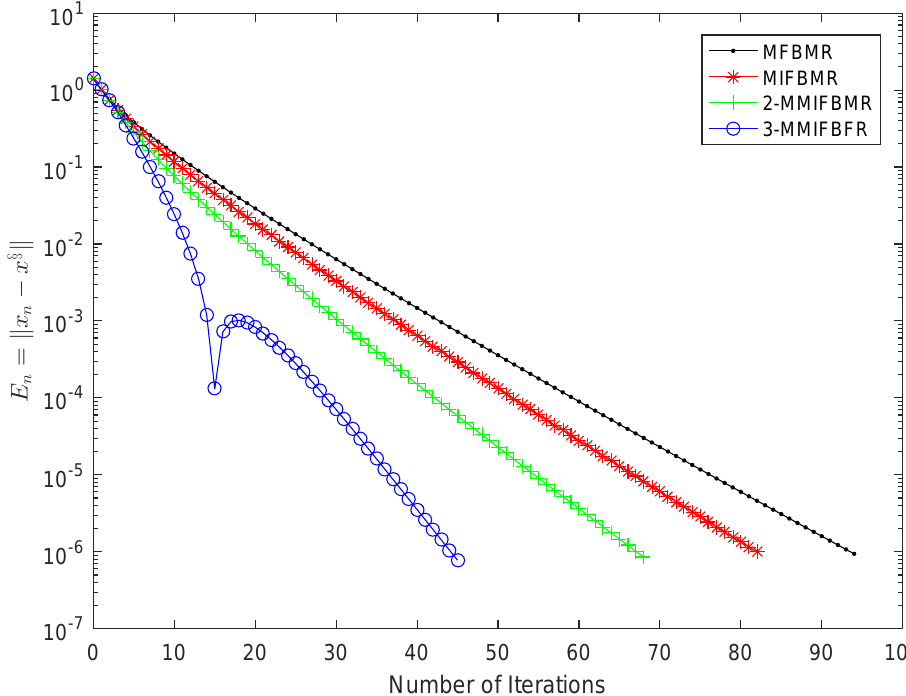
Figure 5. Comparison of MFBMR, MIFBMR, 2-MMIFBMR and 3-MMIFBMR in Example